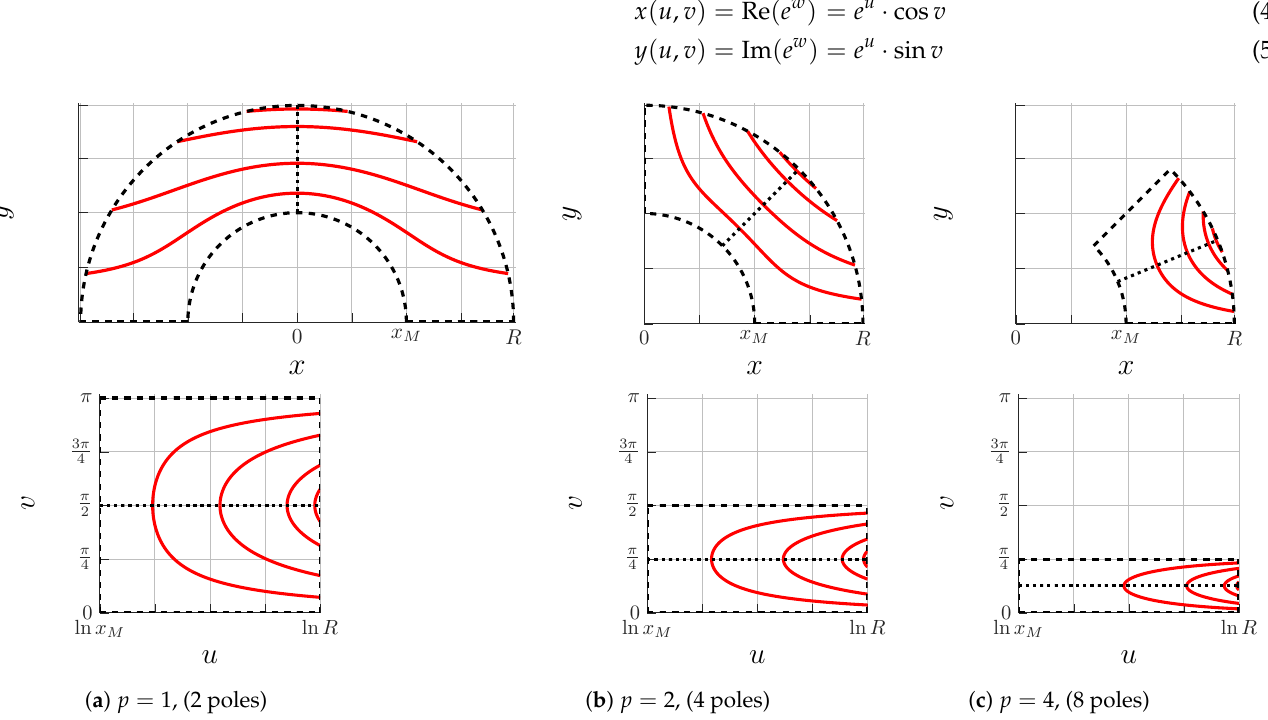
Figure 10. Real z -plane (upper row); Conformal mapping to w = ln z plane (bottom